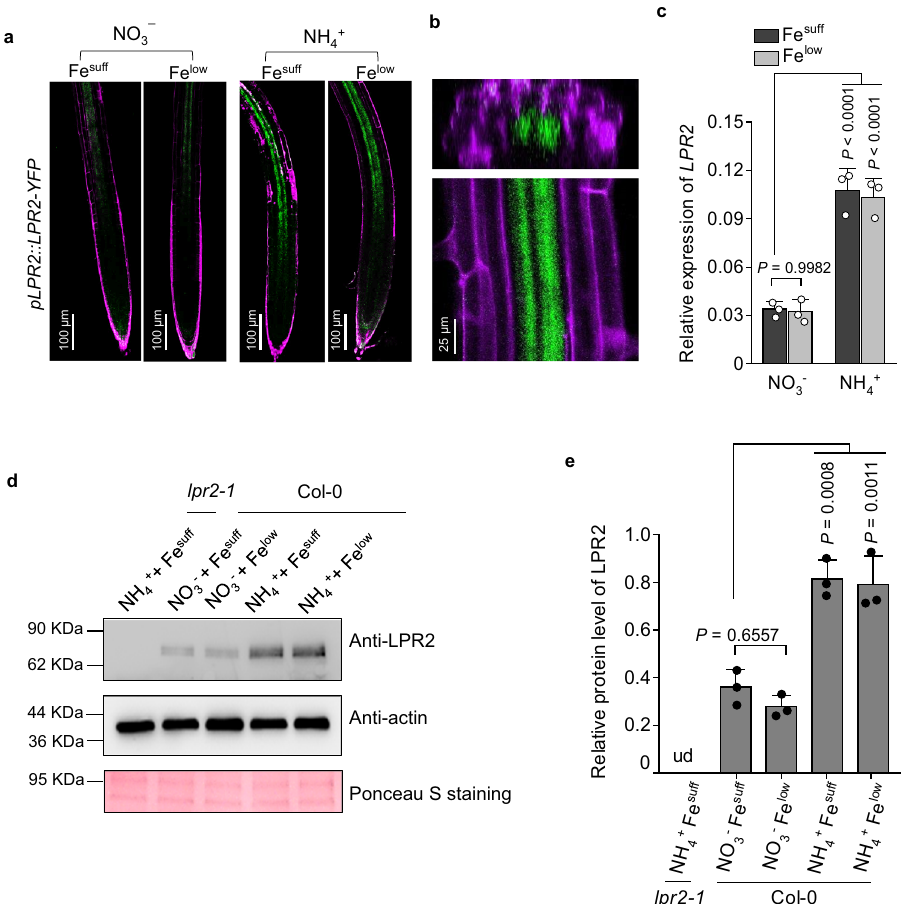
Fig. 4 Distribution of LPR2 in roots and its response to NH4 + . a pLPR2::LPR2-YFP expression in primary roots of complementation line COM#7. Roots were counterstained with propidium iodide (purple fl uorescence) and analyzed for YFP fl uorescence (green). b Radial section (top) and close-up view (bottom) of pLPR2::LPR2-YFP expression in a root of a COM#7 seedling grown in Fe suff NH 4 + medium. c LPR2 expression in Col-0 roots. Relative expression levels were normalized to the geometric mean of expression of UBQ10 and EF1 α . d , e Representative gels and relative protein levels in Col-0 roots. Relative LPR2 levels were estimated from the ratio of the signal intensity of LPR2 to that of actin from the same sample. c , e Data shown are mean ± SD of three biological replicates. P values < 0.05 indicate signi fi cant differences (two-way ANOVA with post-hoc Tukey HSD test). Four-day-old seedlings of the indicated genotypes were transferred to NO 3 − or NH 4 + medium with Fe suff (100 µ M) or Fe low (10 µ M) and analyzed 4 days after seedling transfer. Each experiment was repeated independently three times with similar results, and a representative experiment is